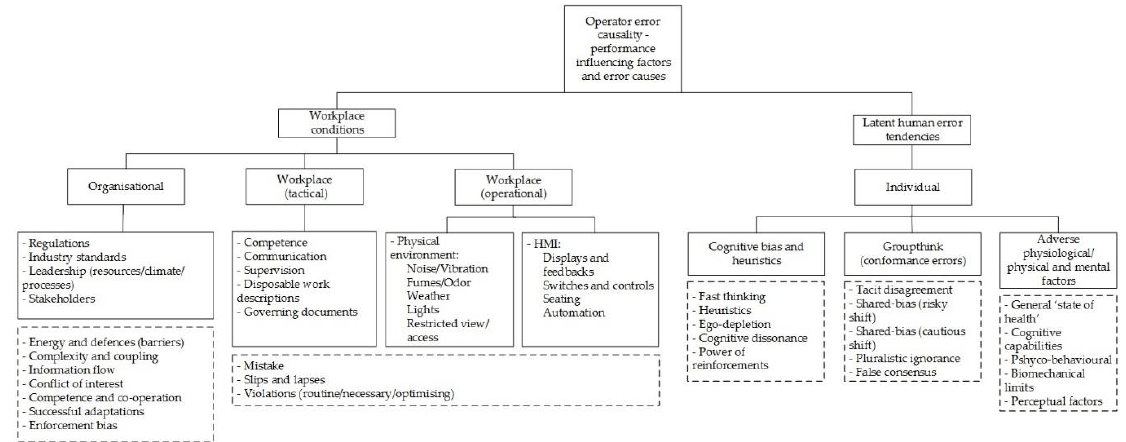
Figure 5. Generic causal classification scheme showing latent human error tendencies and workplace conditions as influencing factors associated with operator error causes (based on [1,19,21,48]).